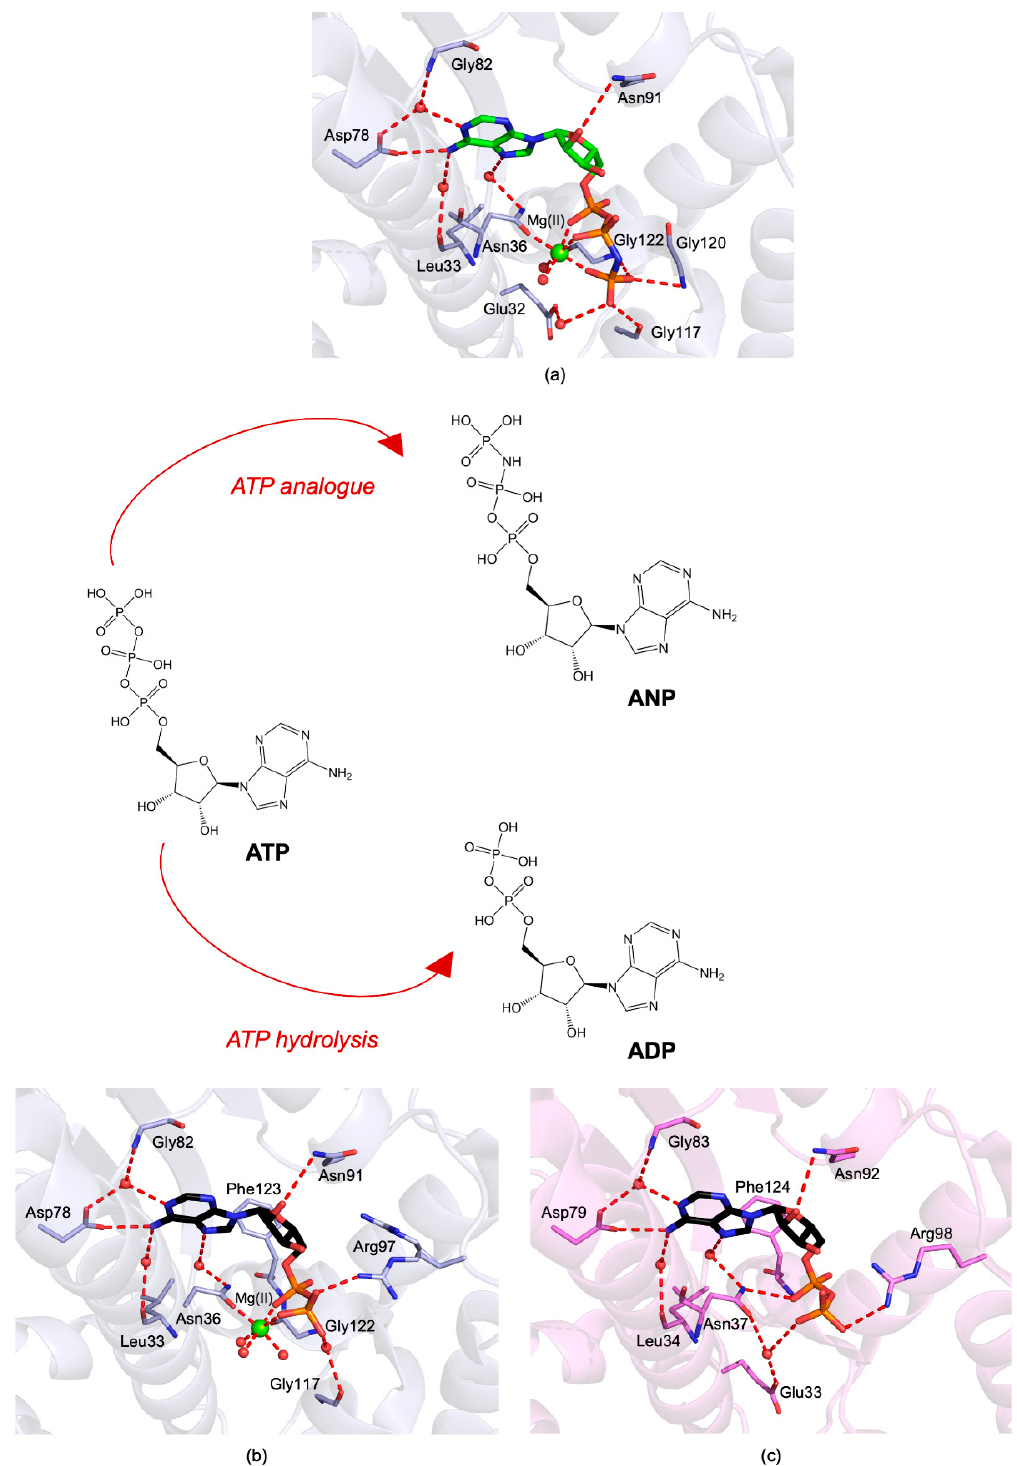
Figure 4. Active-site view of ( a ) Lm -NTD (light blue cartoon and carbons) in complex with phosphoaminophosphonic acid–adenylate ester (ANP, in sticks, green carbons; PDB id 3H80, unpublished results); ( b ) Lm -NTD (light blue cartoon and carbons) in complex with ADP (in sticks, black carbons; PDB id 3U67, unpublished results); ( c ) Pf -NTD (violet cartoon and carbons) in complex with ADP (in sticks, black carbons; PDB id 3K60 [66]). In all figures, hydrogen bonds are displayed as red dashed lines; the Mg(II) ion and water molecules are displayed as green and red spheres, respectively; oxygen atoms are colored red, nitrogen blue, and phosphorus orange.